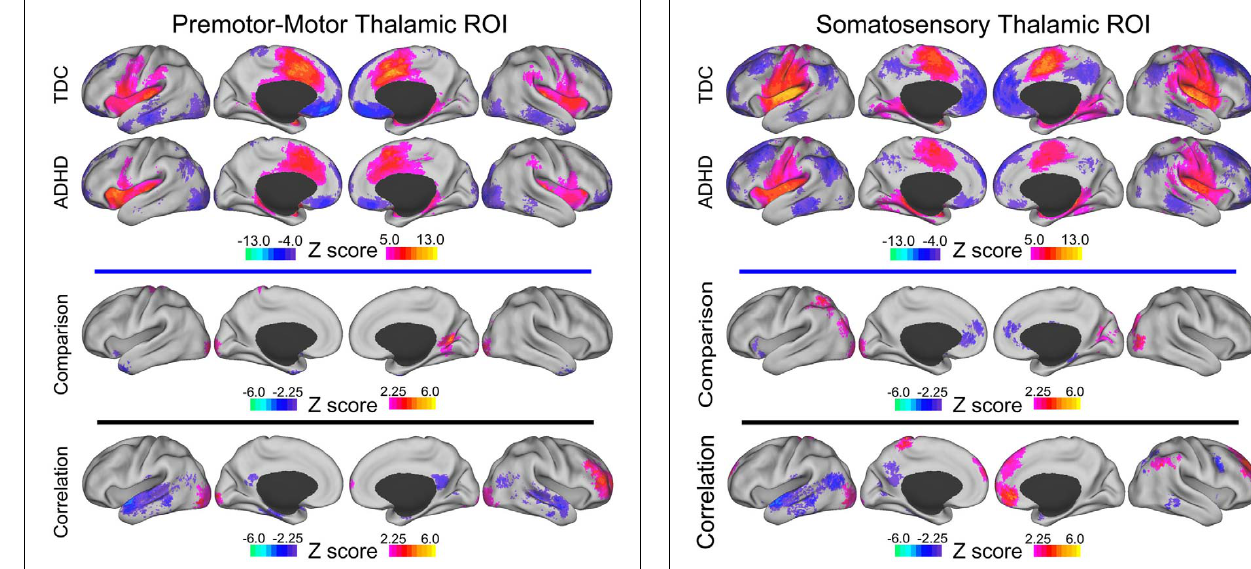
FIGUREA5 | Somatosensory thalamic voxelwise maps projected onto cortical surfaces. Each row displays the cortical surface for each voxelwise map generated from the somatosensory thalamic ROI: group maps for TDC, group maps for ADHD-C, maps from the comparative analysis (TDC vs. ADHD-C), and maps from the correlation analysis. Cortical surface projection was performed with the (PALS)-B12 atlas (Van Essen, 2005) and the software Caret (Van Essen et al.,